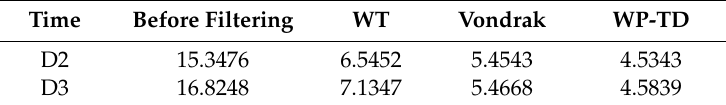
Table 7. The RMS value of the DD coordinate residual sequences of the adjacent days corrected by the almost noiseless multipath obtained in the reference day